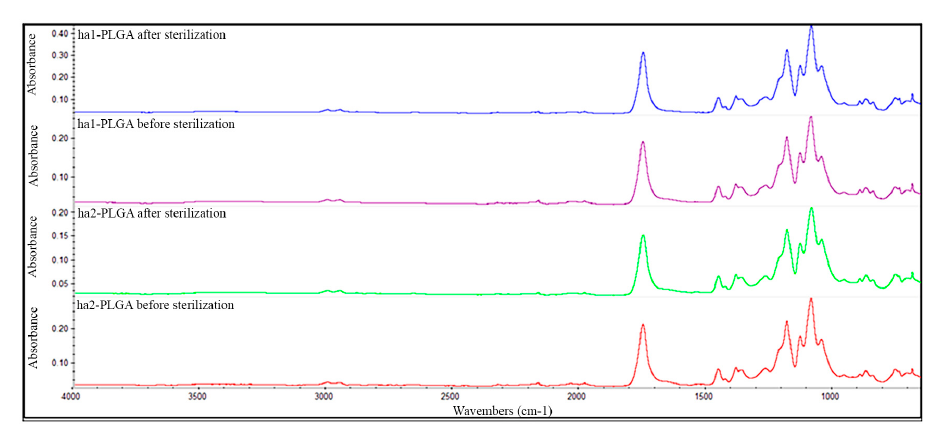
Figure 3. Representative FTIR spectra of ha1- and ha2-PLGA fleeces before and after sterilization. The spectra show no di ff erence in the chemical composition of neat ha1- and ha2-PLGA fleeces before and after sterilization. The functional groups characterizing the PLGA as follows: ester carbonyl stretch (C = O) at 1748 cm − 1 , ether group stretch (C-O-C) at 1085 cm − 1 , and methyl stretching (C–H) and (C–CH 3 ) at 1452 and 1044 cm − 1 ,